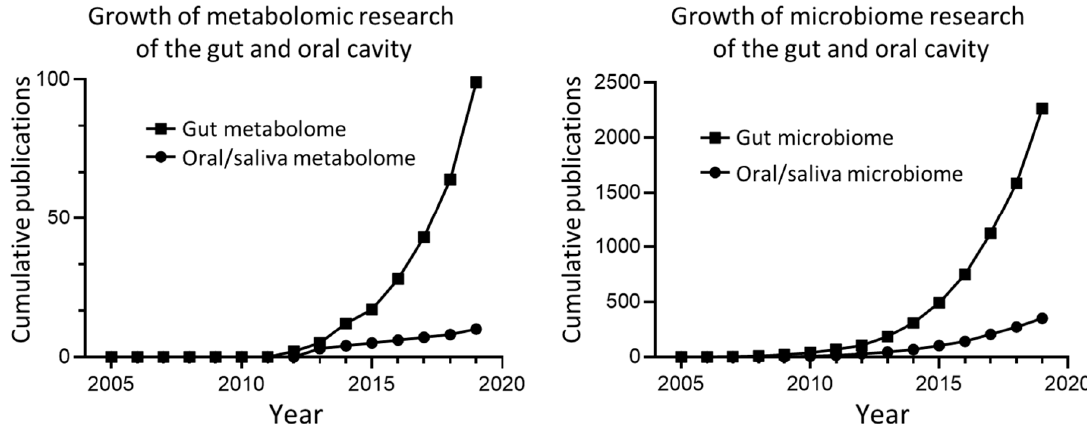
Figure 5. A comparison of the cumulative publications for metabolomics and microbiome studies of the gut and oral cavity. Data was collected from Scopus by searching publications with “gut metabolome”, ”gut microbiome”, ”oral OR saliva metabolome”, and ” oral OR saliva microbiome” in the title field. Note that the total publications for microbiome studies are considerably greater than metabolome studies for both the gut and oral cavity.